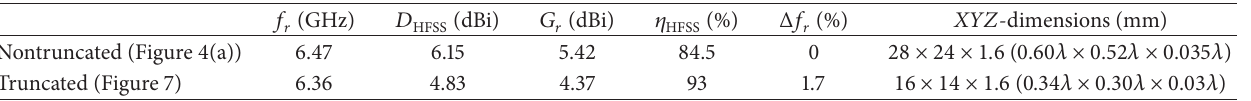
Table 2: The effect of truncation on the SC SE-EBG-RA (2-via); Δ is the change in f and cable are exactly modeled in both cases; G